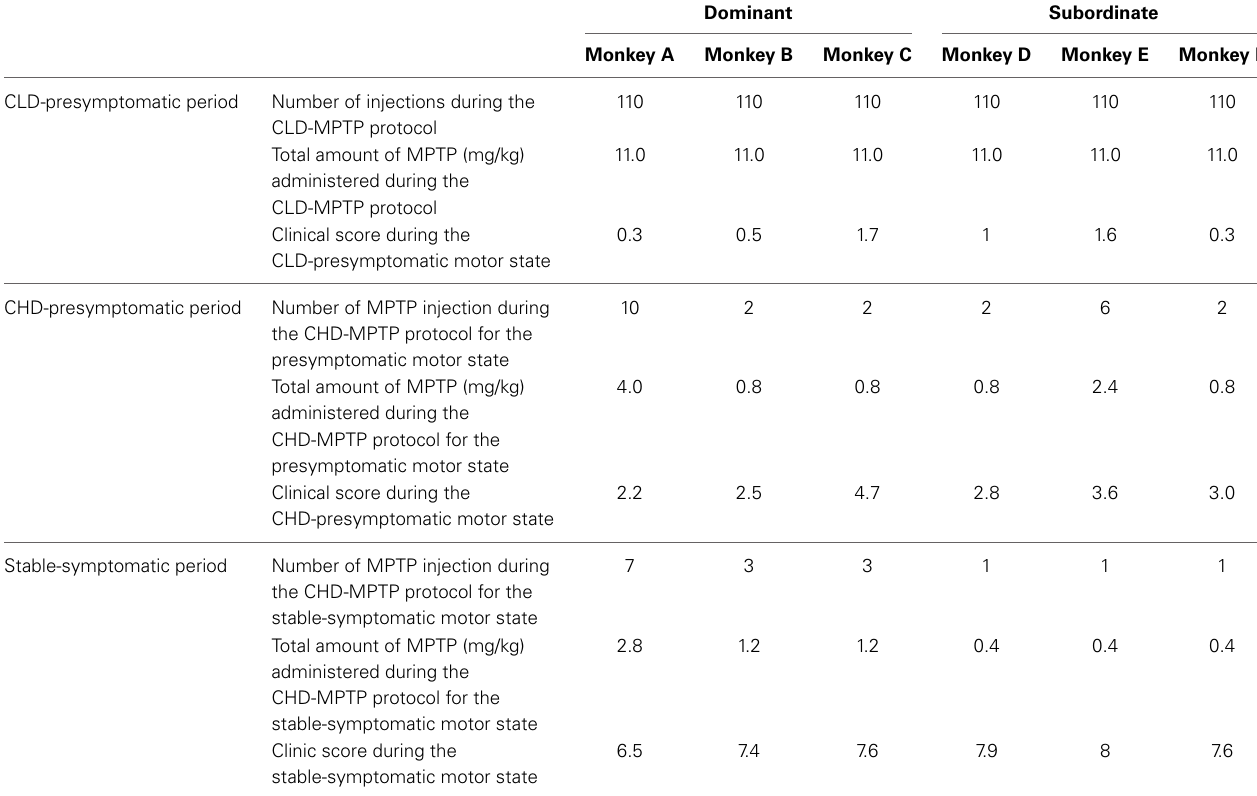
Table 1 | Individual sensitivity to MPTP during the CLD-MPTP and the CHD-MPTP protocols (number of MPTP injections, total amount of MPTP administered (mg/kg) and related clinical